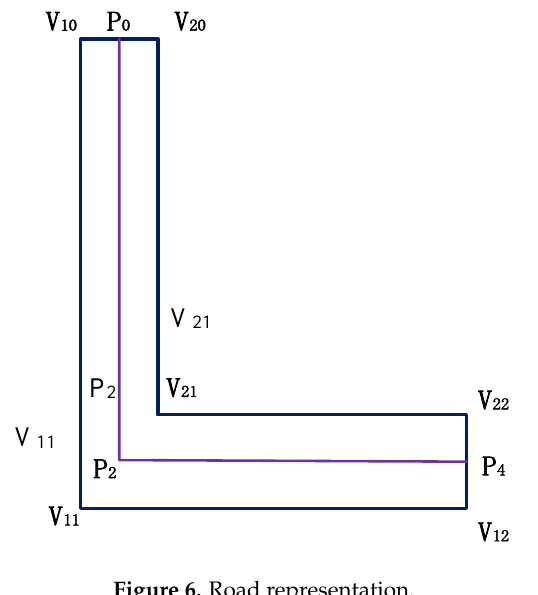
Figure 6. Road Figure 6. Road representation.